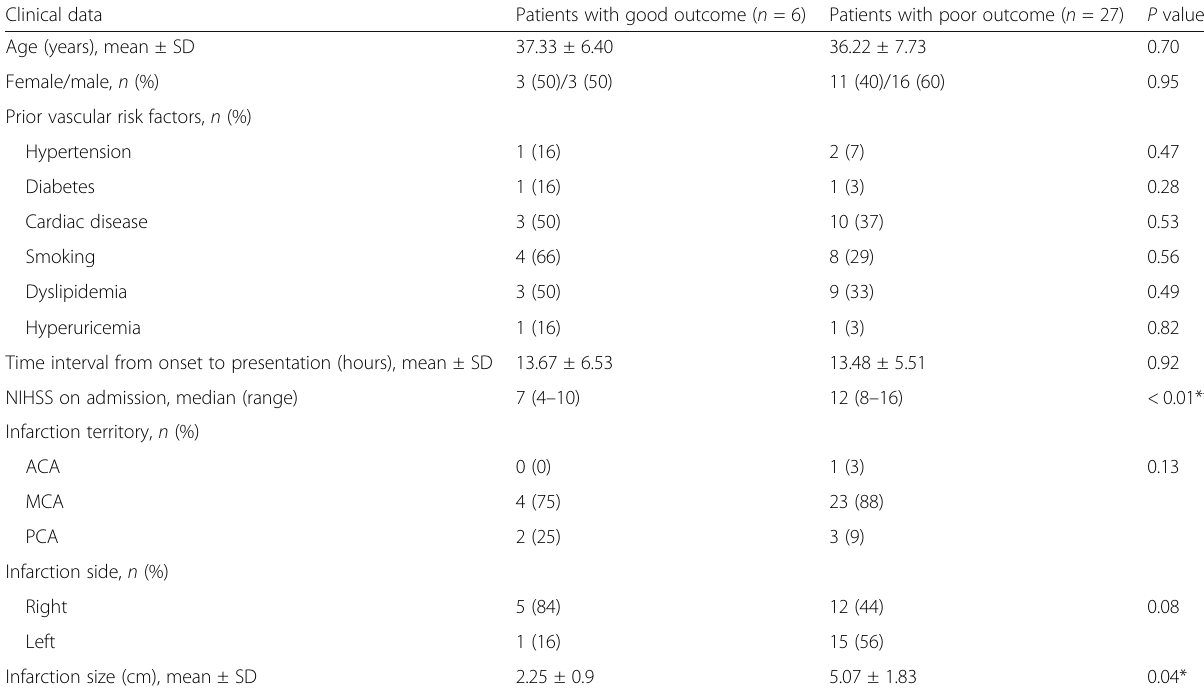
Table 3 Comparison between patients with good and poor outcomes regarding the demographic and baseline clinical and radiological characteristics Clinical data